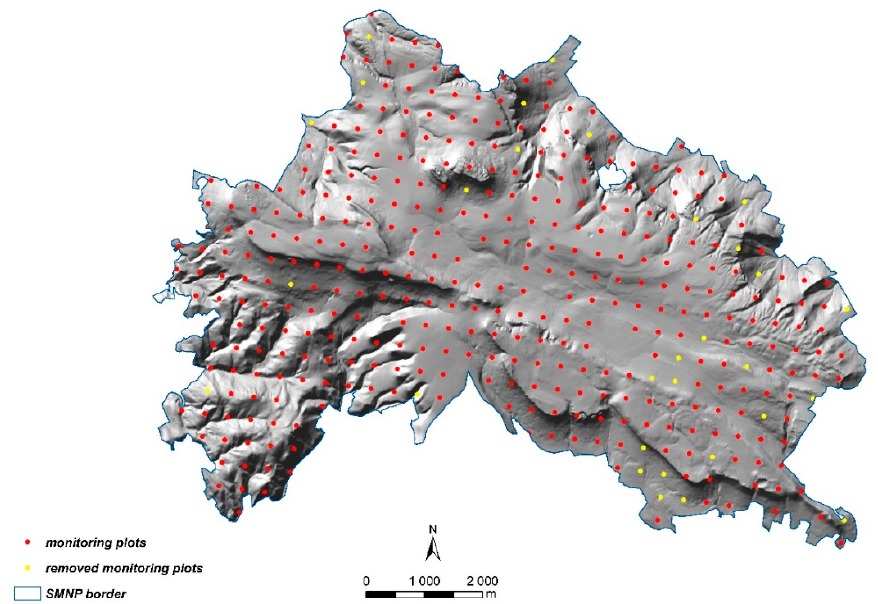
Figure 4. Location of 357 plots (red circles) in the reduced monitoring network (RMNet). Yellow circles represent removed monitoring plots.